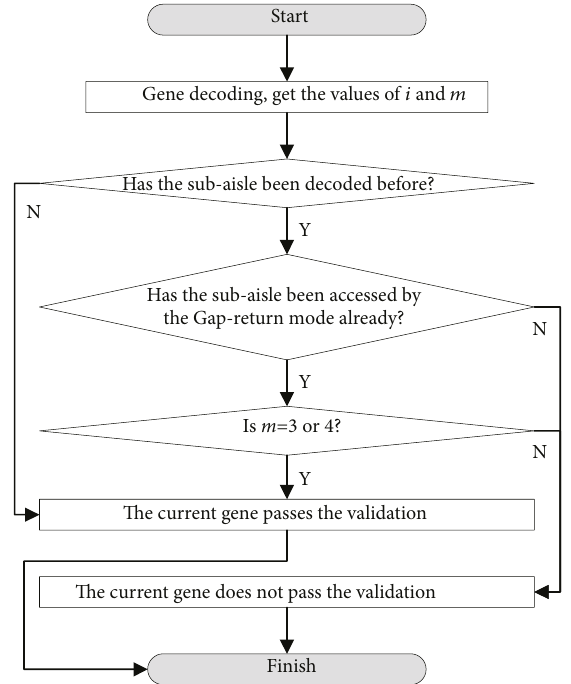
Figure 7: The procedure of validation for each single